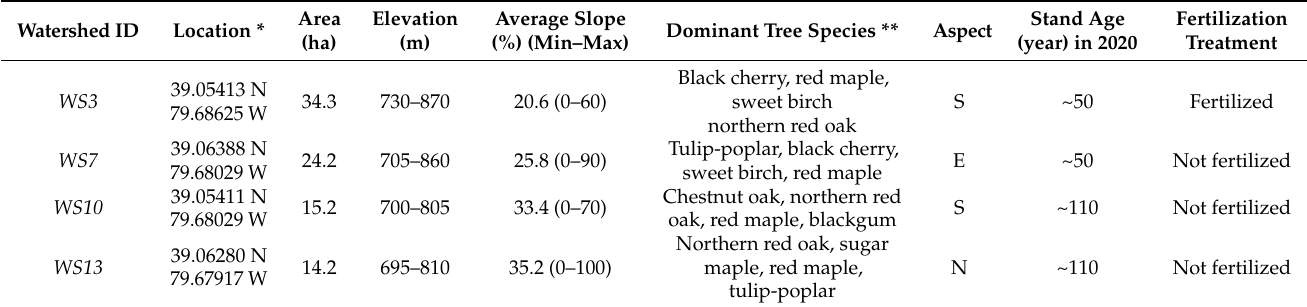
* Lowest point in the watershed, i.e., the location of the stream weir. ** Tree species are listed in order of descending dominance (see text below).